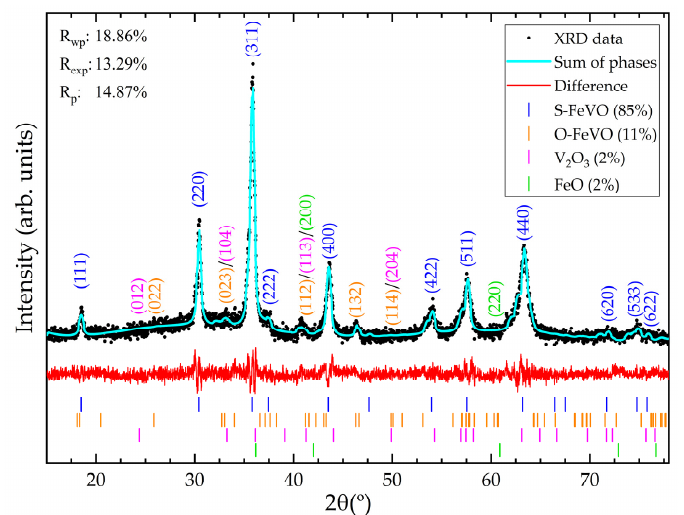
Figure 2. Multi-phase Rietveld refinement at ambient conditions of S-FeVO including the additional minor phases. Black dots are the measured pattern. The solid cyan line is the overall calculated Rietveld profile. The difference between the observed and calculated data is shown with a red line. Tick marks indicate the calculated Bragg peak positions. Relevant reflections are labelled with their corresponding Miller indices.